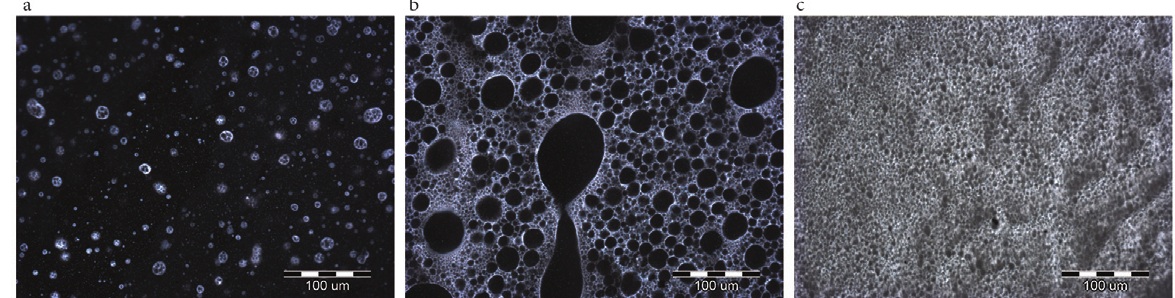
Fig. 5. Examples of microscopic images of modified bitumens structure (reference section length is of 100 µ m): a – 50/70 (3% SBS); b – 50/70 (6% SBS); c – concentrate (9%